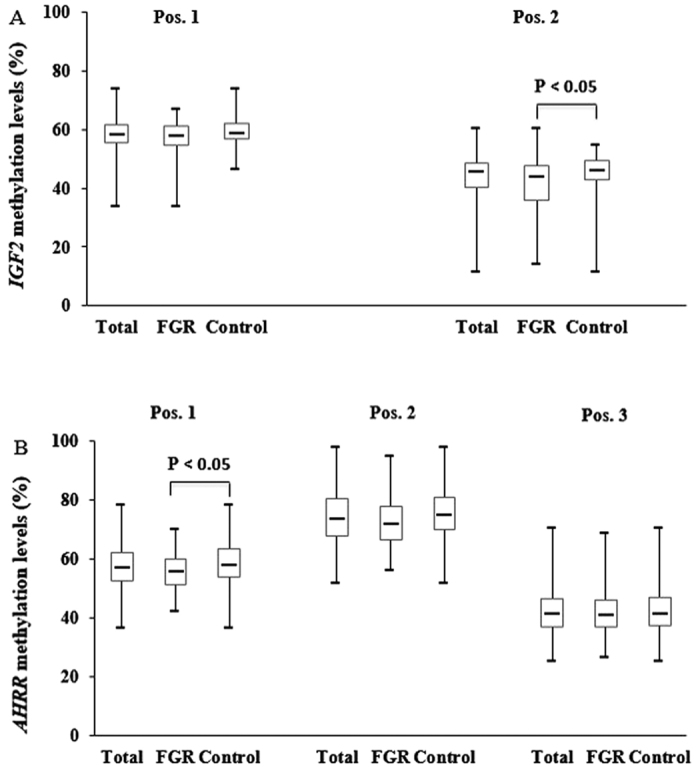
Placental DNA methylation levels of IGF2 and AHRR.(A) IGF2 methylation levels. (B) AHRR methylation levels. Solid bar indicates median; upper and lower limits of box, 75th and 25th percentiles; upper and lower bars, maximum and minimum values, respectively.